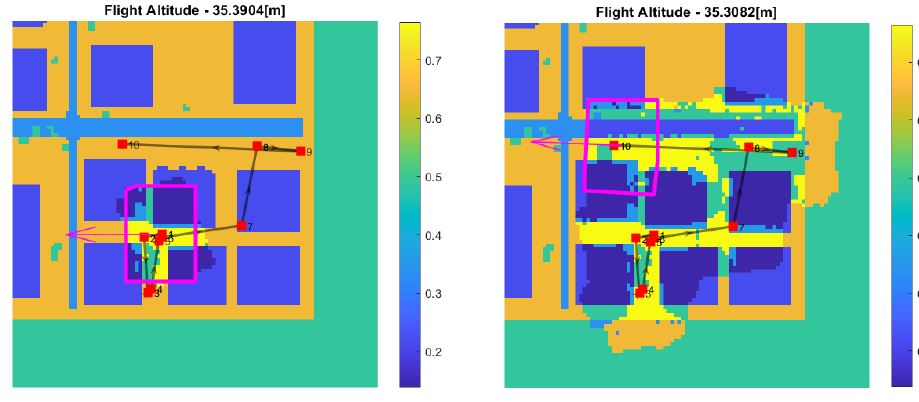
Figure 11. Bernoulli trial update: each cell is updated only once.